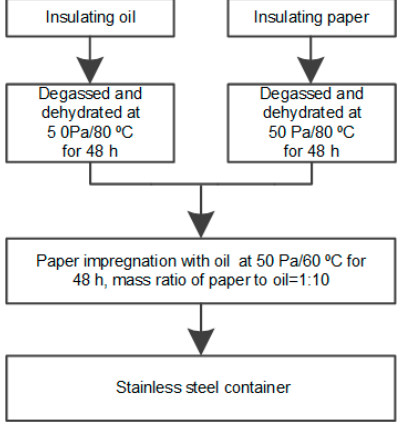
Figure 1. Sample processing procedure. Table 1. Thermal aging temperature and corresponding aging time.